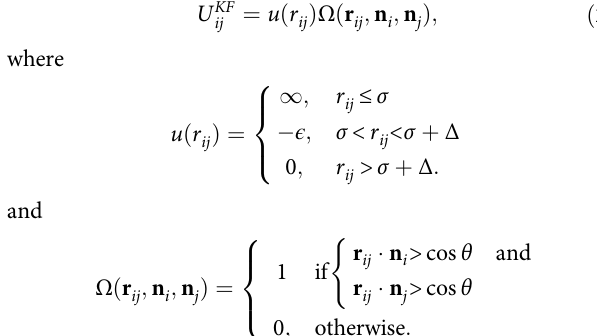
Fig. 2 Phase diagram for the self-assembly of patchy particles for n = 100 particles. The average cluster size ( M ) as a function of temperature ( T ) and concentration ( c ) is seen. The cluster size is given by the color and ranges from M = 0 (purple) to M = 100 (red). We observe three phases: the liquid and condensed phase are divided by a coexistence phase (gray area). Coexistence is characterized by a bimodal distribution that can be detected with a shift in the bimodality coef fi